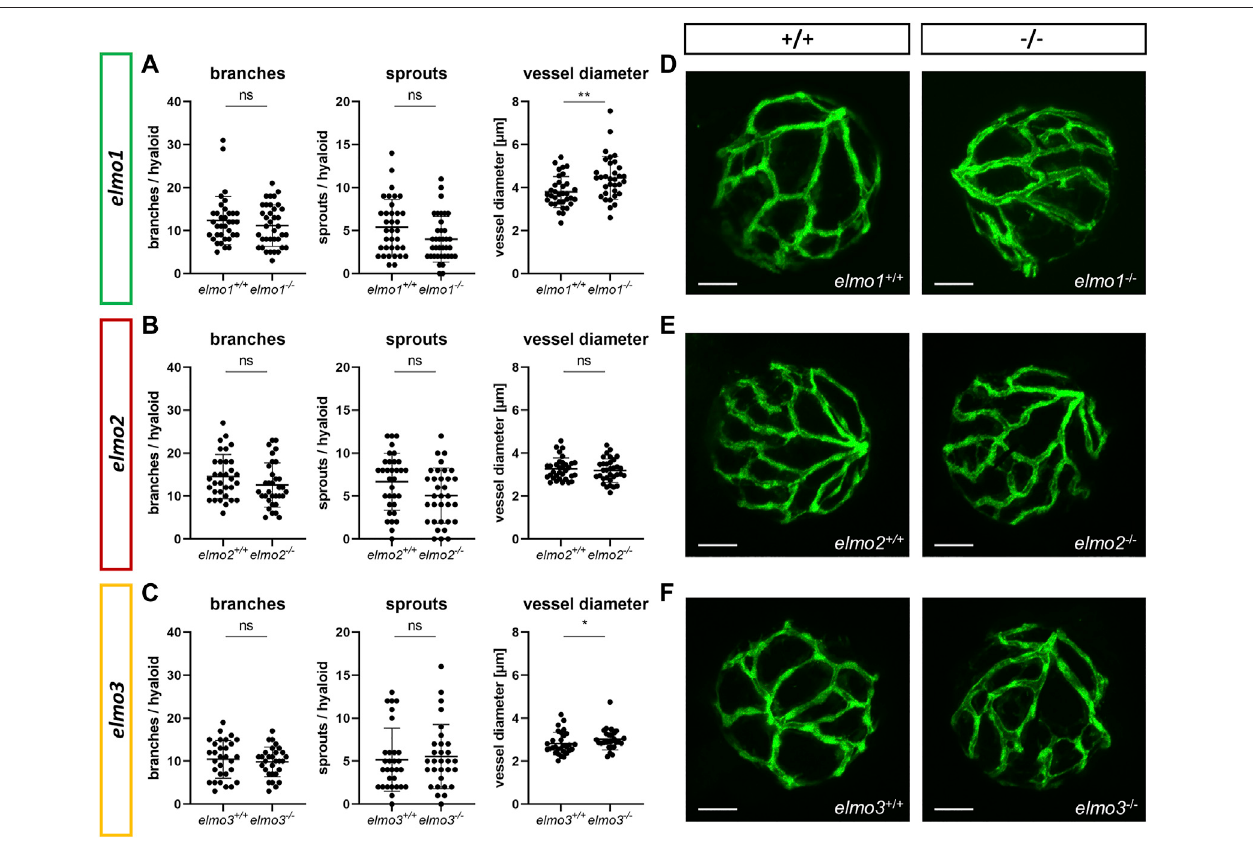
FIGURE 2 | The loss of Elmo1 and Elmo3, respectively, led to an increased diameter of hyaloid blood vessels in zebra fi sh larvae. (A) Quanti fi cation of larval hyaloid vasculature at 120 hpf showed no changes in branches and sprouts but an increase in the vessel diameter in elmo1 − / − compared to elmo1 +/+ . n = 33 – 37 hyaloids per group. (B) Quanti fi cationoflarvalhyaloidvasculatureat120 hpfshowednochangesinbranches,sproutsandvesseldiameterin elmo2 − / − comparedto elmo2 +/+ . n =33 hyaloidspergroup. (C) Quanti fi cation oflarvalhyaloidvasculatureat120 hpfshowednochangesinbranchesand sproutsbut anincreaseinthevessel diameterin elmo3 − / − compared to elmo3 +/+ . n = 27 – 31 hyaloids per group. (D – F) Representative confocal microscopy images of the hyaloid vasculature of elmo1 +/+ and elmo1 − / − (D) , elmo2 +/+ and elmo2 − / − (E) and elmo3 +/+ and elmo3 − / − (F) zebra fi shlarvaeat120 hpf.Scalebaris50 µm.Statisticalanalysiswasdonewith t -testandMann-Whitney test. * p < 0.05, ** p < 0.01. ns, not signi fi cant; hpf, hours post